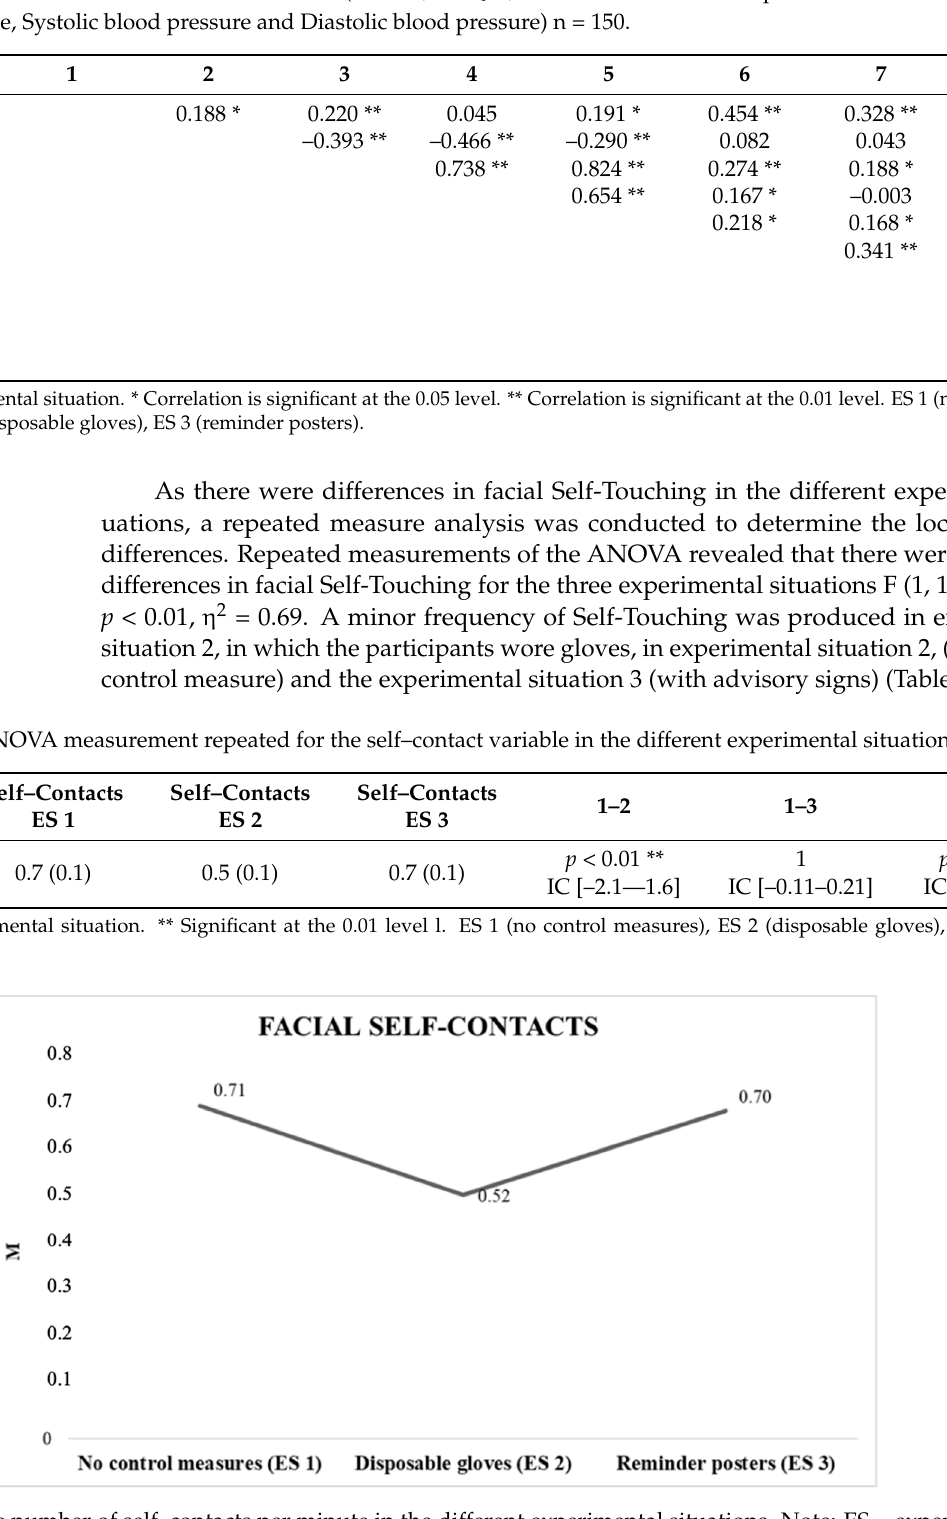
Figure 2. Average number of self–contacts per minute in different experimental situations according to anxiety levels. Note: ES = experimental situation. ES 1 (no control measures), ES 2 (disposable gloves), ES 3 (reminder posters). And as can be seen in Figure 3, intra–group differences were found (F (1,2) = 6.61, p < 0.01, η 2 = 0.04, observed potency = 0.87) and inter–group (F (1,2) = 25.38, p < 0.01, η 2 = 0.14, observed potency = 0.99).